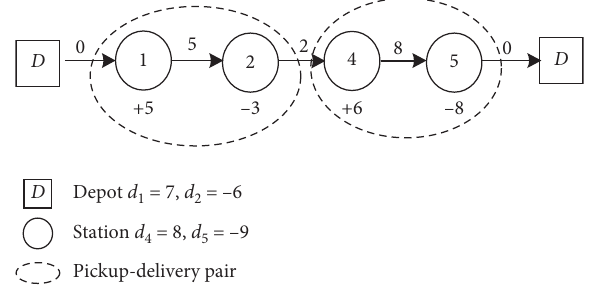
Figure 2: Illustration of pickup-delivery